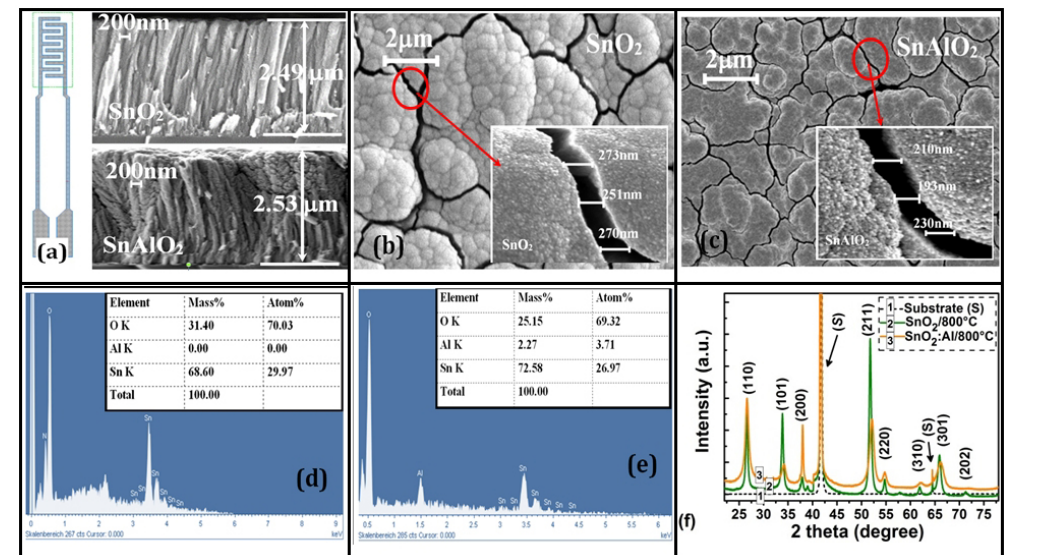
Figure 1. Structural and morphological characteristics of the sensing layers. (a) Schematic of Al 2 O 3 sensor platforms with inter-digital electrodes (IDEs) and FE-SEM micrographs of both layers at the cross section confirming the columnar structure. (b) and (c) FE-SEM micrographs of SnO 2 and SnO 2 :Al layers, respectively, showing grain size differences and the insets showing the cracks generated during annealing. (d) and (e) EDX spectra of SnO 2 and SnO 2 :Al layers, respectively. (f) The X-ray diffractograms of c-cut single crystal sapphire Al 2 O 3 substrate (1), SnO 2 (2) and SnO 2 :Al (3). The sensing layers were ex situ annealed at a temperature of 800 ◦ C in static air, the peak from (0006) the plane of c-cut sapphire Al 2 O 3 is denoted as “S”. Table 1. Deposition conditions for the undoped and Al-doped SnO 2 coatings. Layer p chamber (bar) p O (sccm) p Ar (sccm) P Sn (W) P Al (W) Sputter 2